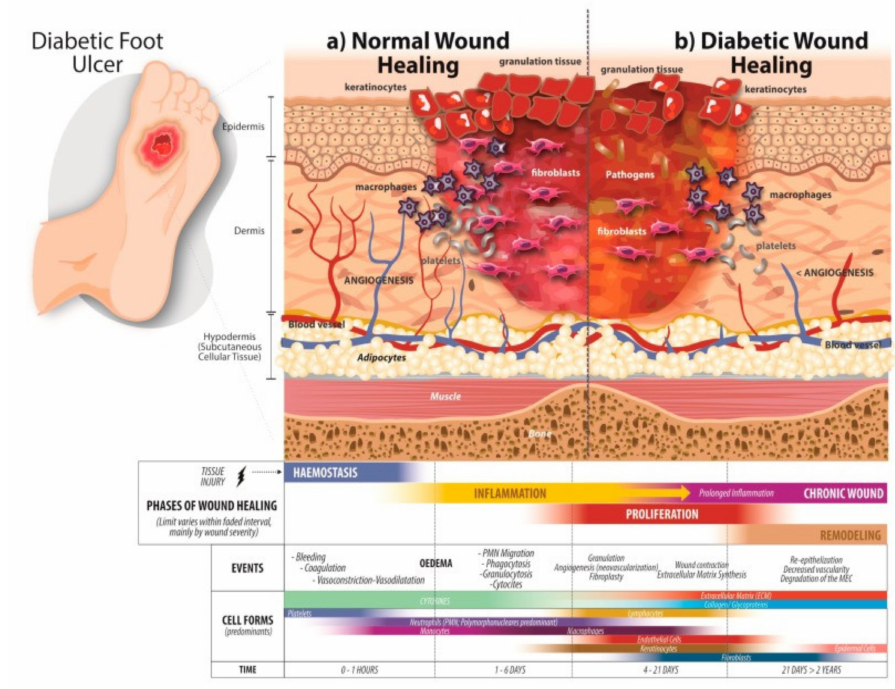
Figure 1. Wound healing phases. ( a ) Normal wound healing phases. In healthy people, wound closure consists of several processes that occur sequentially: rapid hemostasis that involves platelet aggregation to form the platelet plug; an inflammation phase where neutrophils, macrophages,